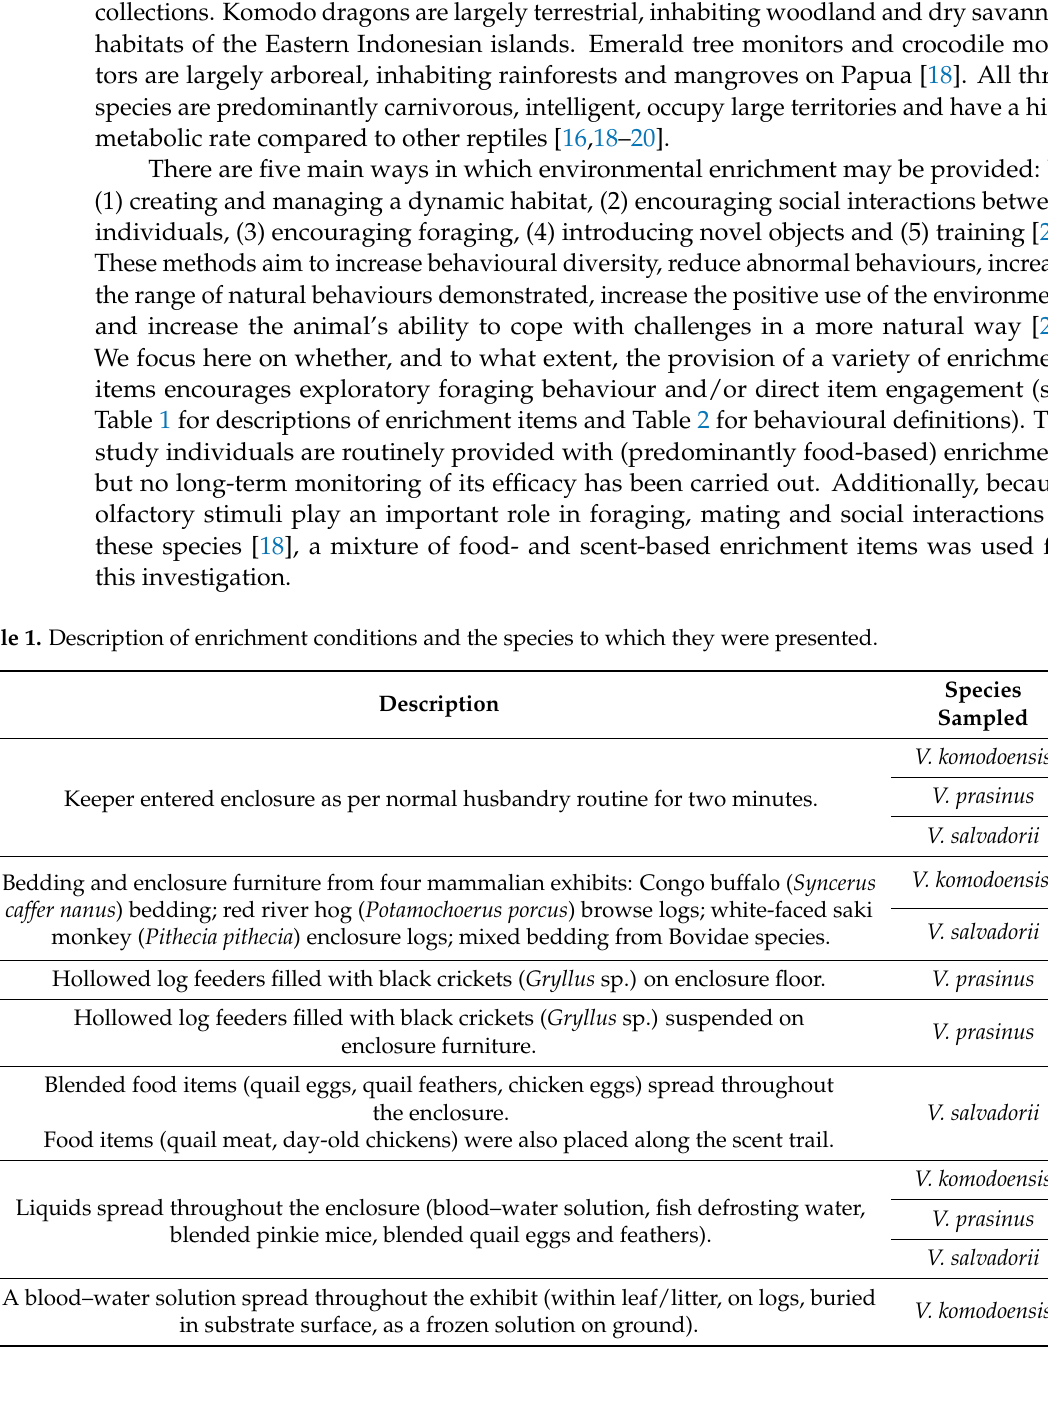
Table 1. Description of enrichment conditions and the species to which they were presented.